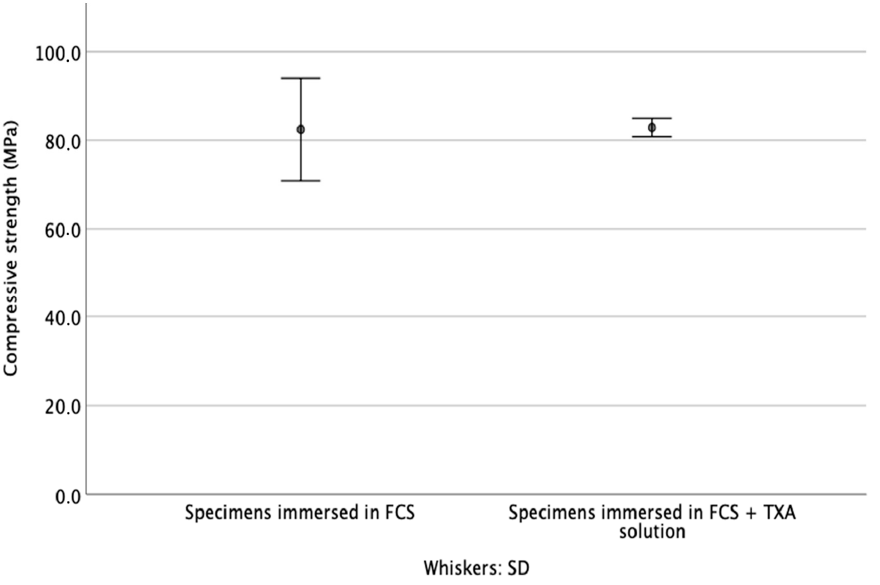
Figure 5. Summary of the compressive strength of the cements, after 7 d of immersion in the test fluids.